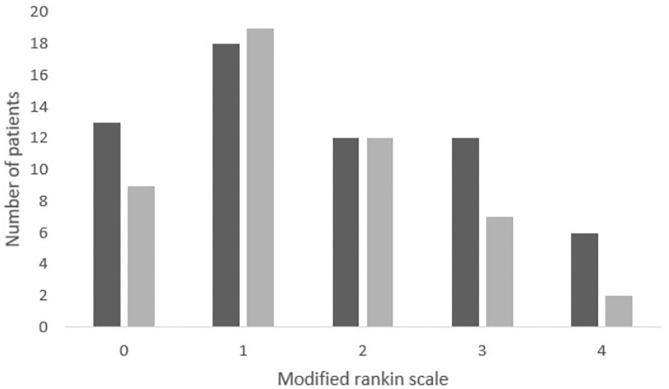
Distribution of the mRS in the patient population. The number of patients in each mRS category. We included 22 patients with a mRS score of 0 (18.8%), 41 with a mRS score of 1 (35.0%), 24 with a mRS score of 2 (20.5%), 21 with a mRS score of 3 (17.9%), and 9 with a mRS score of 4 (9.9%). The shaded proportion of the columns bars indicate the patient who completed both the PROMIS questionnaire and the NRS-11 questionnaire.